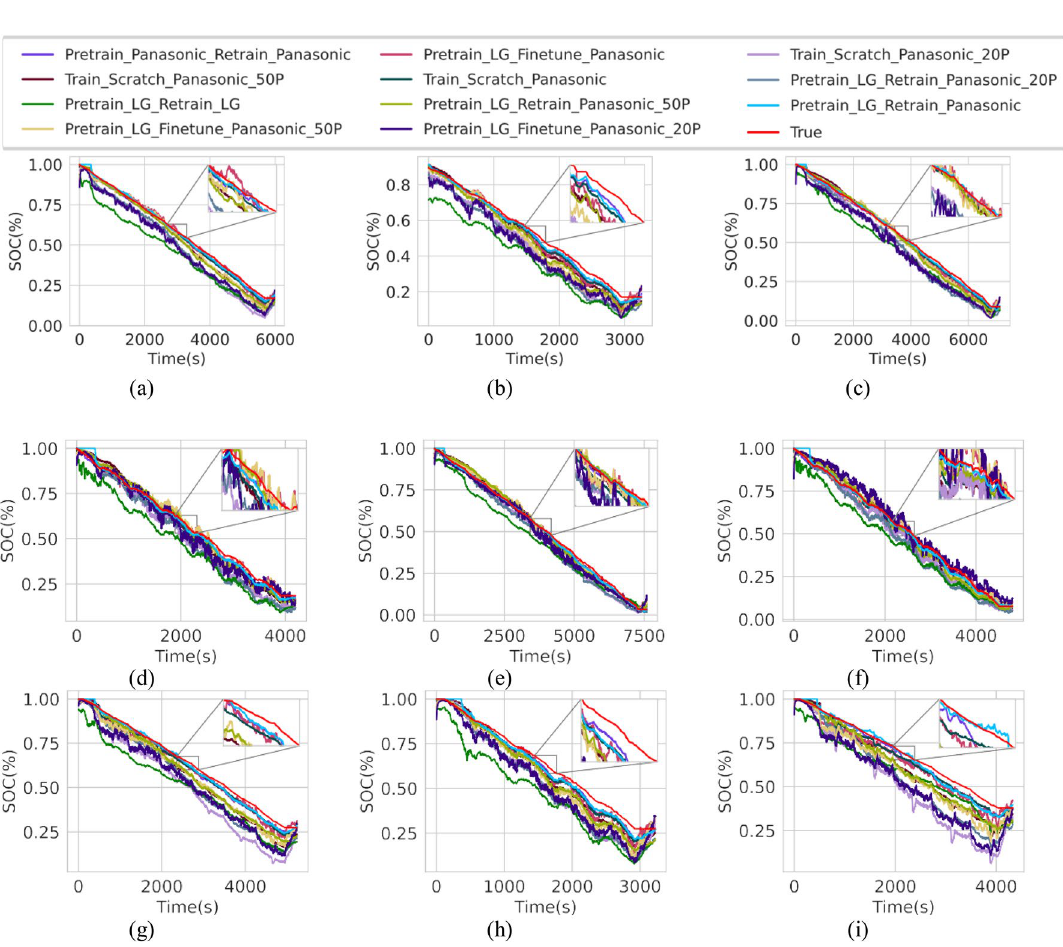
Figure 4. Estimation plot on the test drive cycles of the Panasonic cell with various training combinations. ( a ) HWFET cycle at 0 °C. ( b ) US06 cycle at 0 °C. ( c ) HWFET cycle at 10 °C. ( d ) US06 cycle at 10 °C. ( e ) HWFET cycle at 25 °C. ( f ) US06 cycle at 25